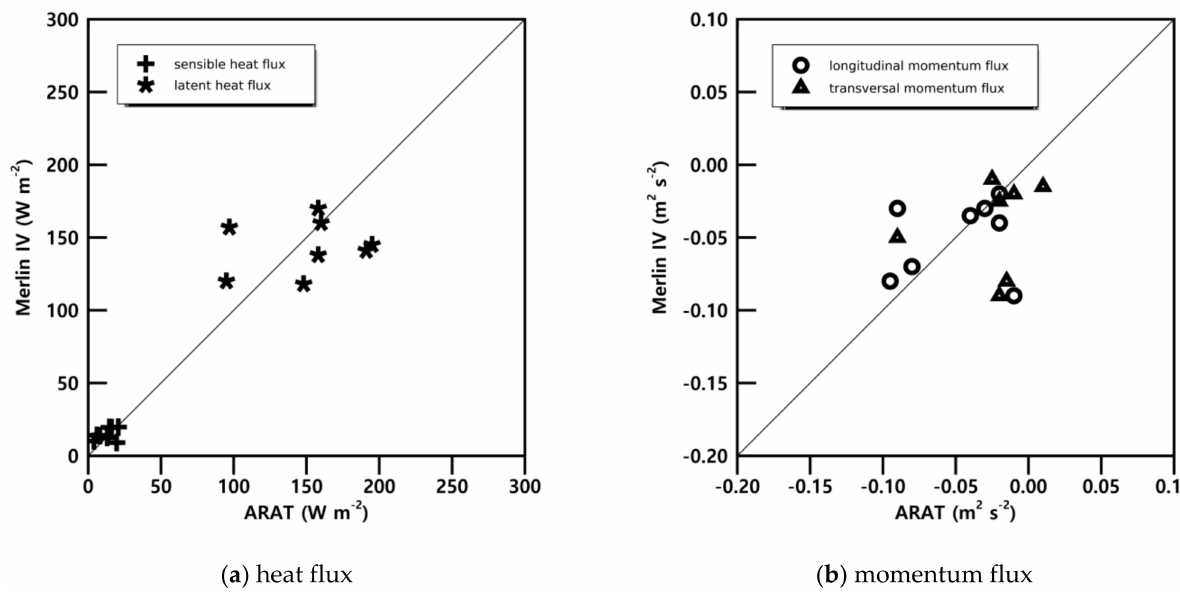
Figure 6. Comparison of ( a ) heat flux and ( b ) momentum flux between the two